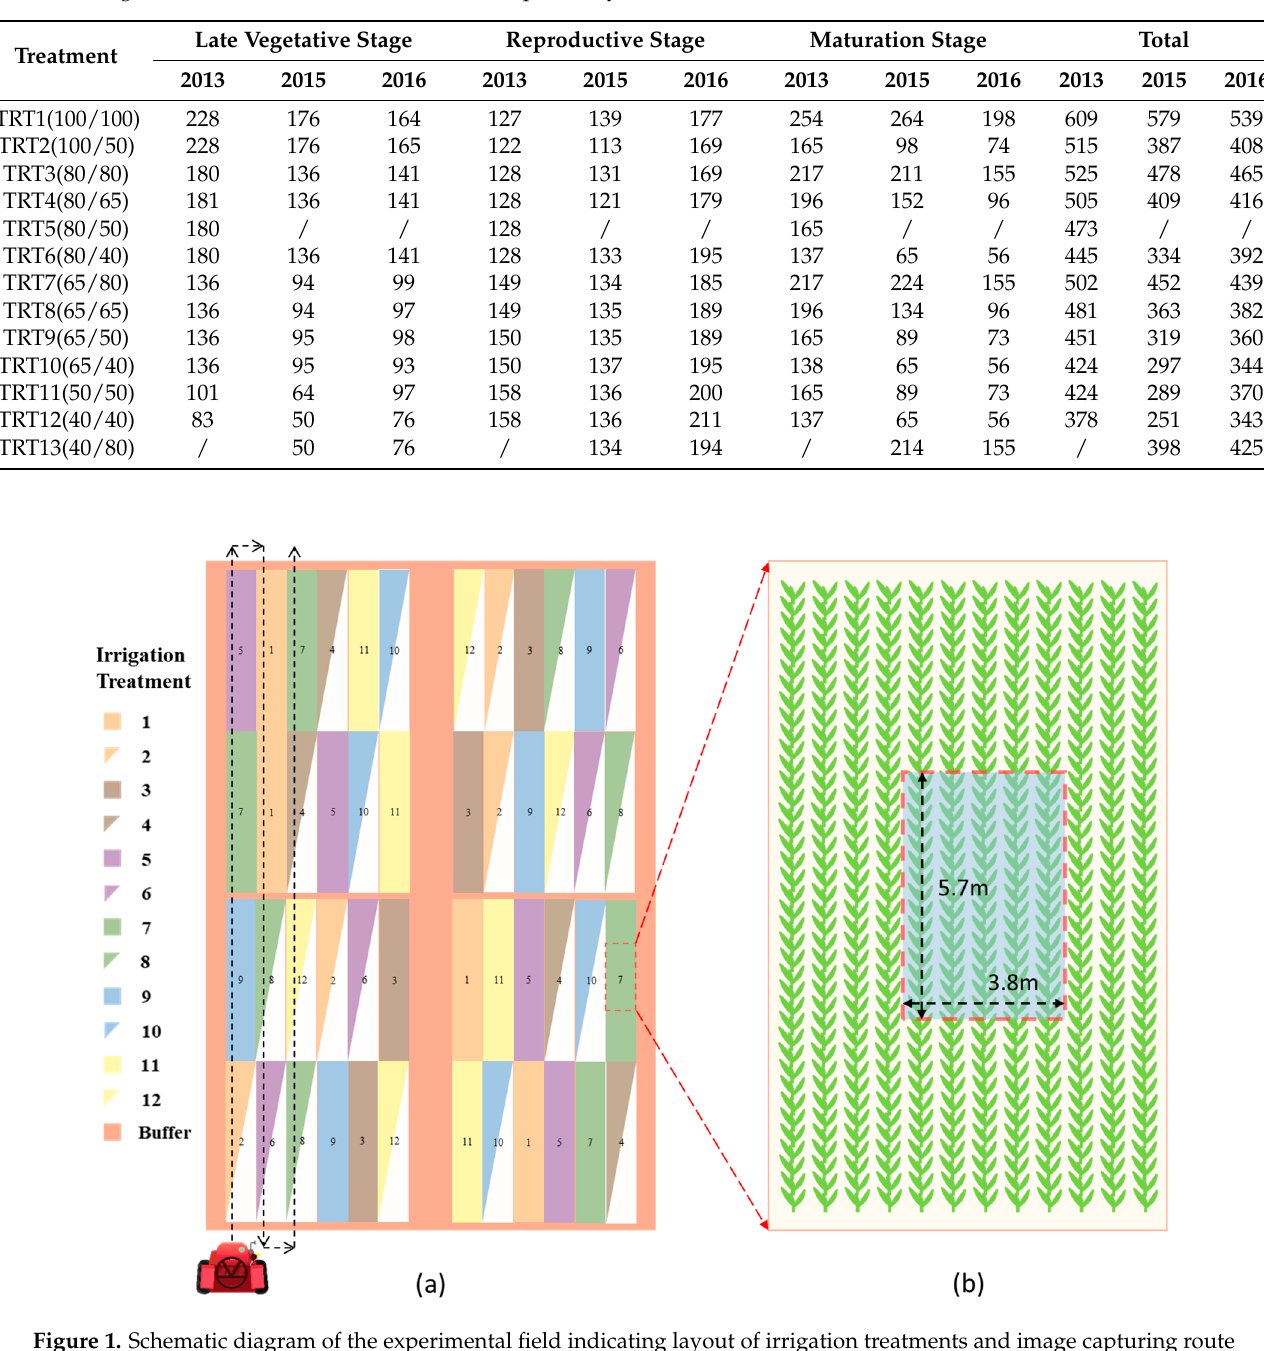
Figure 1. Schematic diagram of the experimental field indicating layout of irrigation treatments and image capturing route ( a ), and location and target view of Red-Green-Blue (RGB) image acquisition ( b ). In 2015 and 2016, irrigation treatment 5 (TRT5) was replaced by TRT13 (Table 1). Table 1. Irrigation treatment and total irrigation and precipitation amount (mm) in different growing stages. In 2015 and 2016, irrigation treatment 5 (TRT5) (80/50) was replaced by TRT13 (40/80).